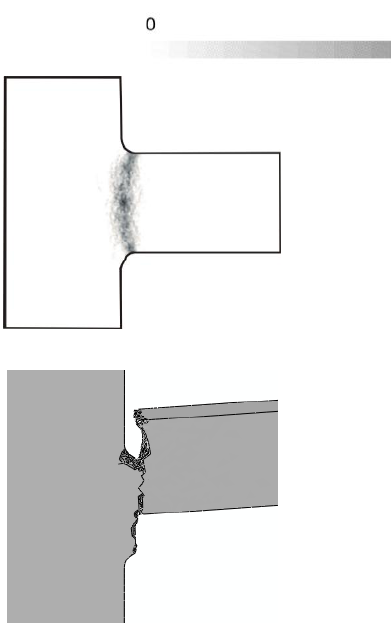
Figure 17. Comparison between (top row) three-scale and (bottom row) two-scale forecasts of the crack patterns at failure, in the case of (left column) tension-dominated loading, and (right column) bending-dominated